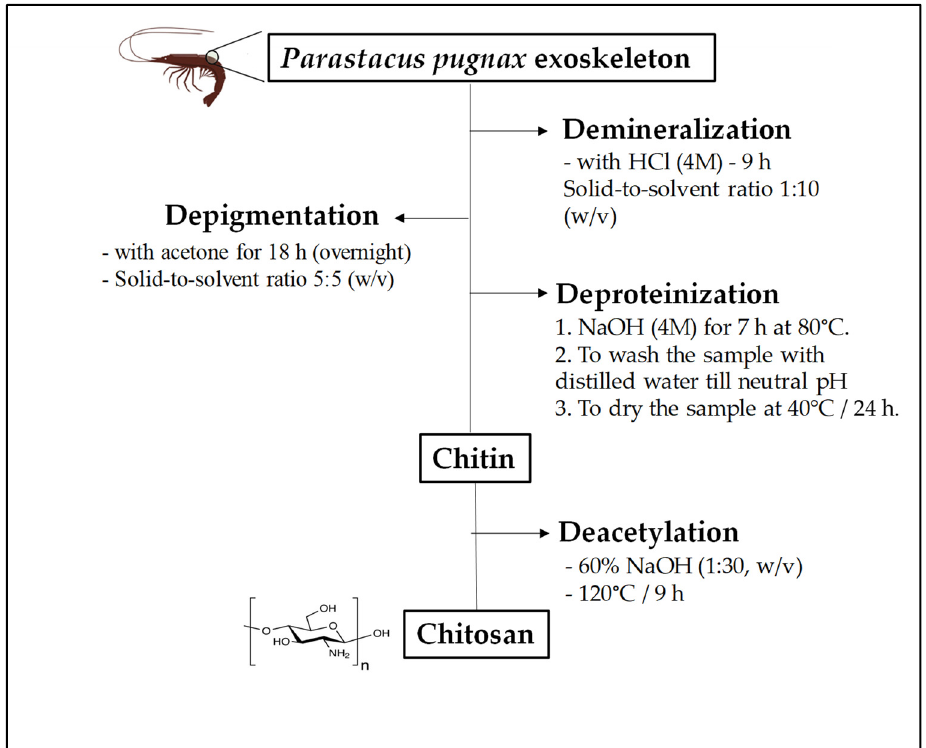
Figure 1. Diagram of production of chitosan from Parastacus pugnax exoskeleton.